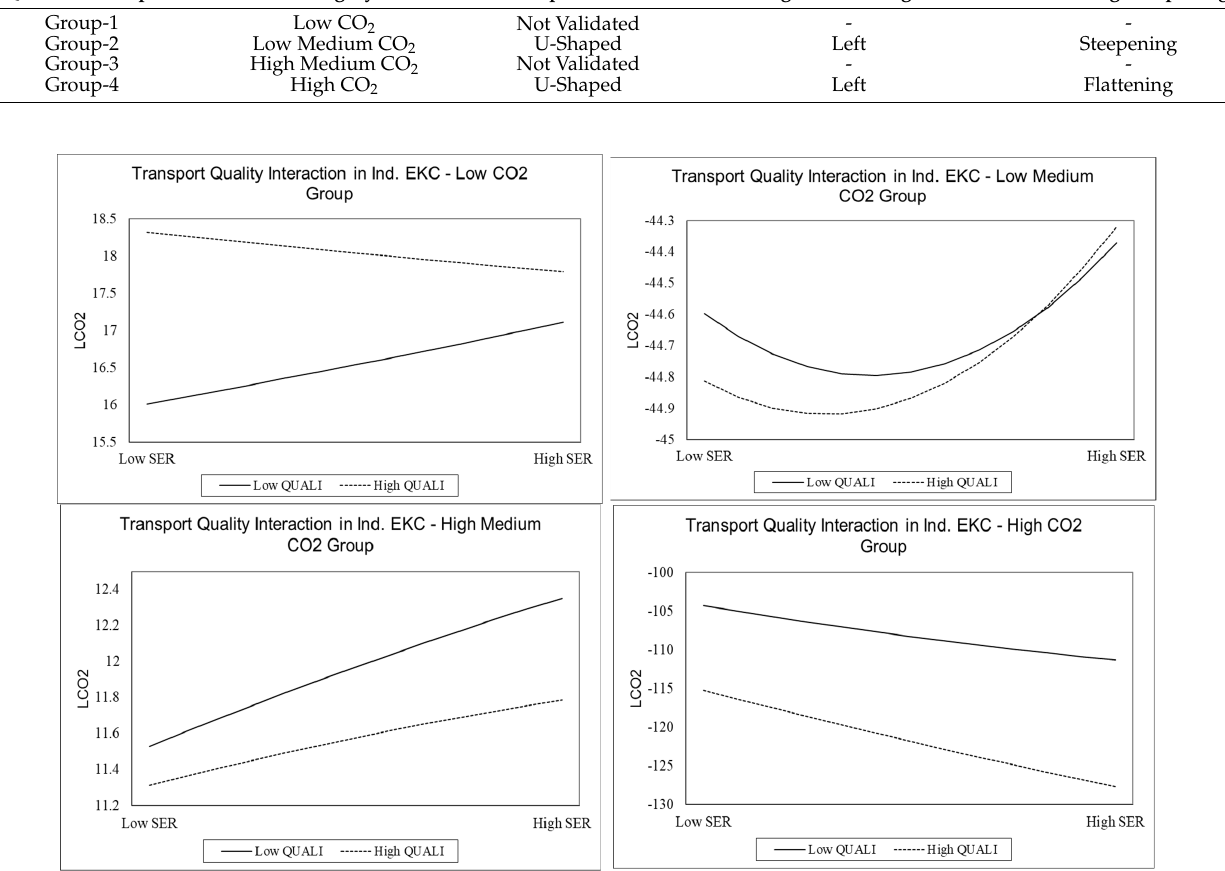
Figure 3. Interaction of Transportation Competitiveness for Services’ EKC.